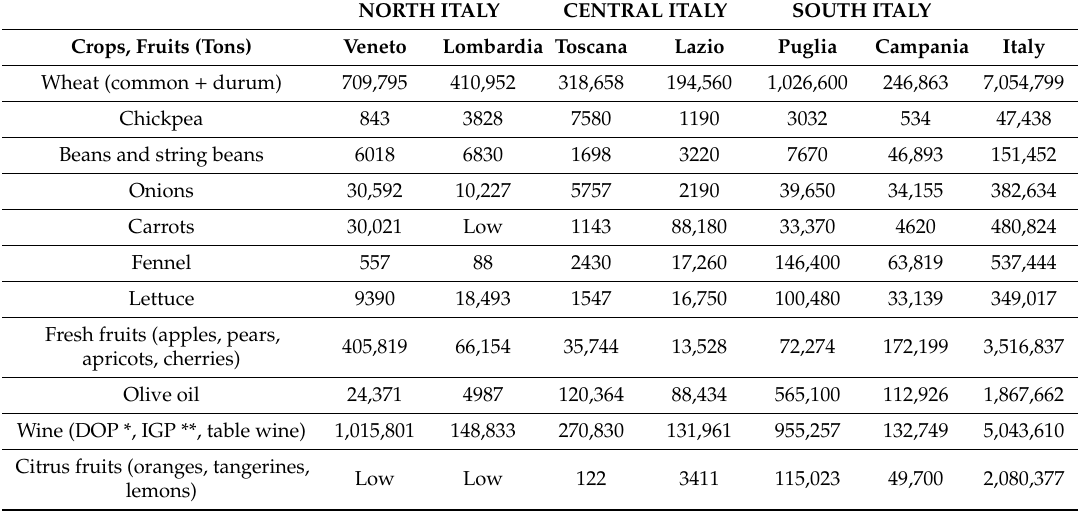
Table 1. The most di ff used cultivations, vegetables and fruits in some administrative regions of North, Central and South Italy with the highest number of biogas plants.